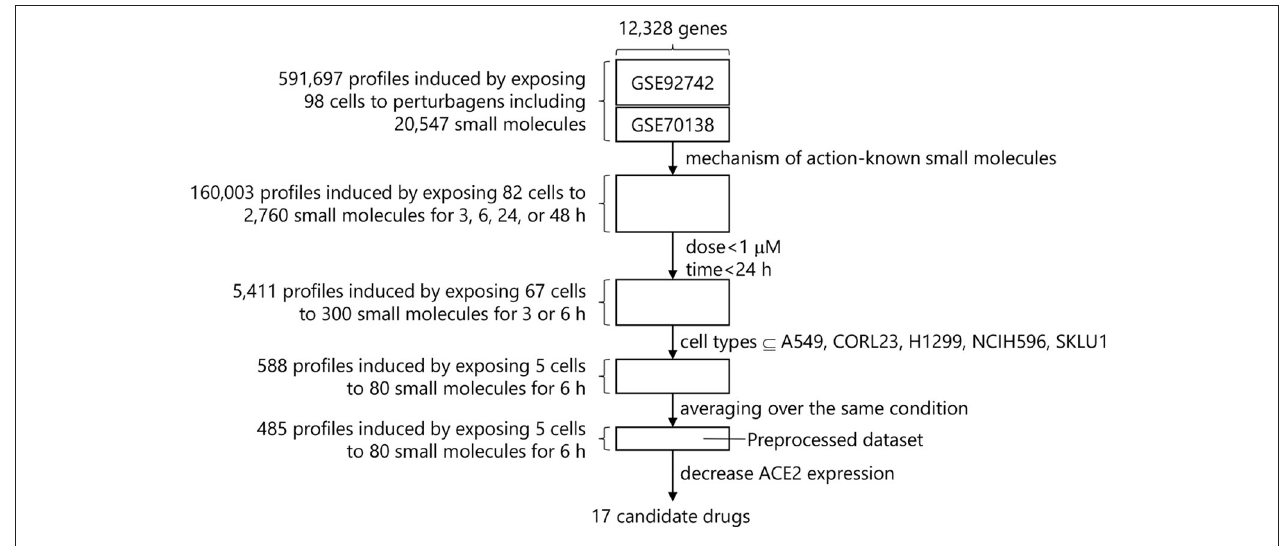
FIGURE 1 | Drug screening process in L1000-based